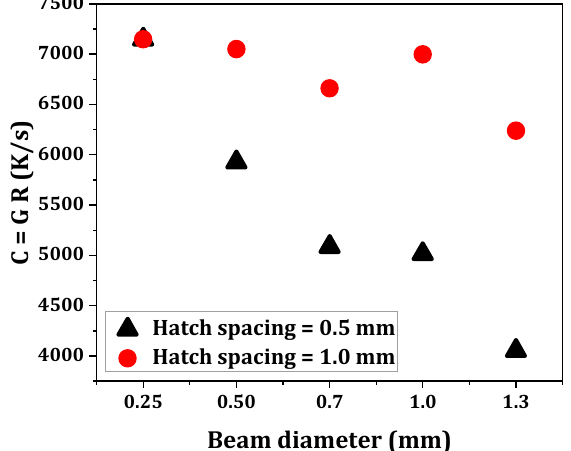
Figure 12. Obtained cooling rates from FEM analysis.